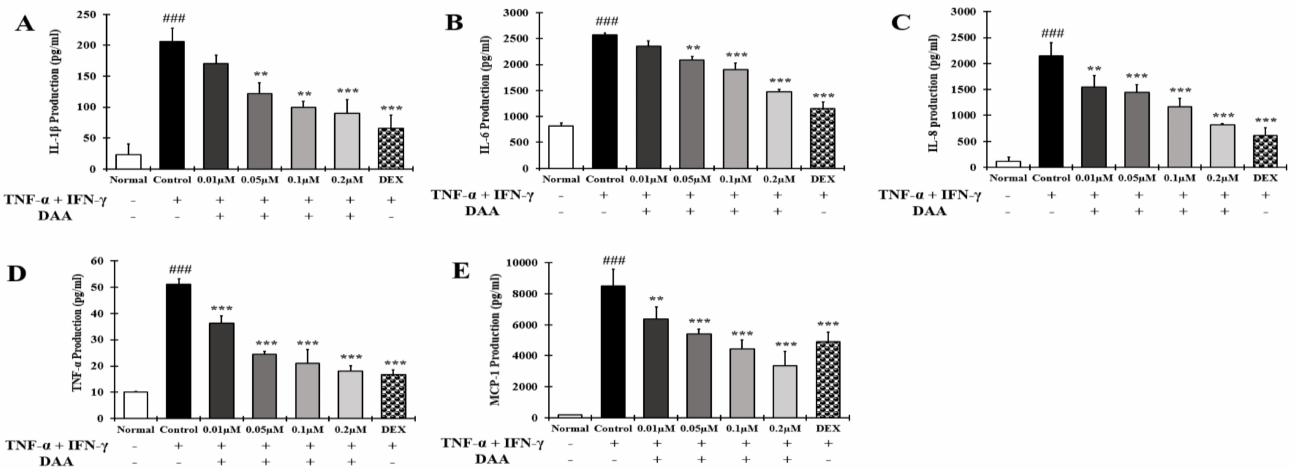
Figure 5. Effect of DAA on AD-related cytokines and chemokines secreted by HaCaT cells. The levels of IL-1 β ( A ), IL-6 ( B ), IL-8 ( C ), TNF- α ( D ), and MCP-1 ( E ) in the supernatant of HaCaT cells were evaluated by ELISA. The results are expressed as the mean ± SD (n = 4). ### p < 0.001 vs. normal; ** p < 0.01 and *** p < 0.001 vs. control; DAA was used at 0.01 µ M, 0.05 µ M, 0.1 µ M, and 0.2 µ M. DEX, the positive control, was used at 0.1 µ